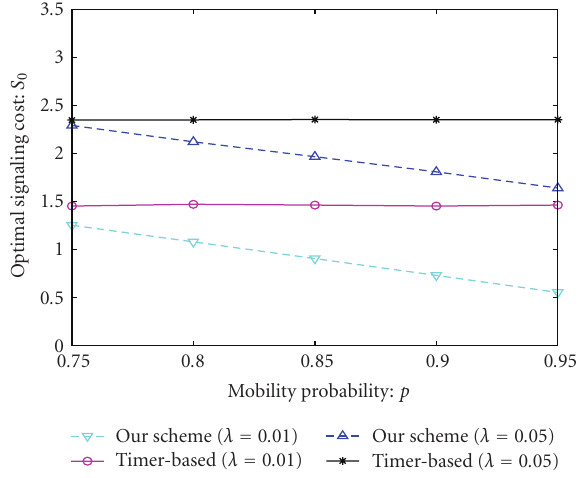
Figure 17: Comparison to timer-based